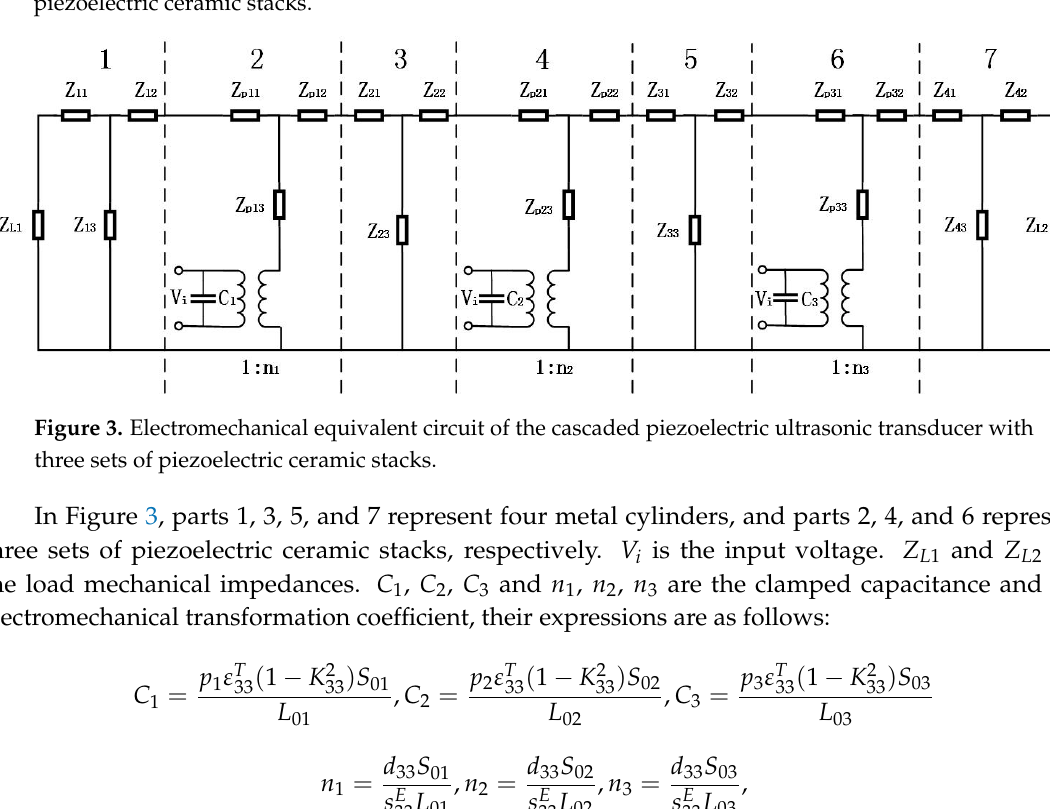
Figure 2. Geometrical diagram of the cascaded piezoelectric ultrasonic transducer with three sets of piezoelectric ceramic stacks.